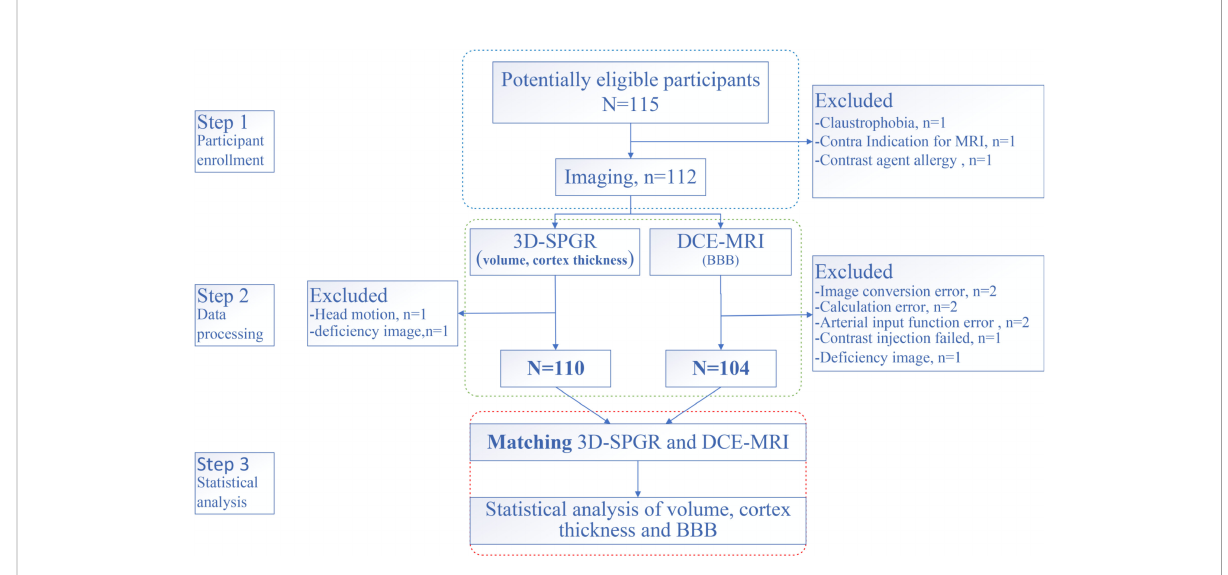
FIGURE 1 Study fl